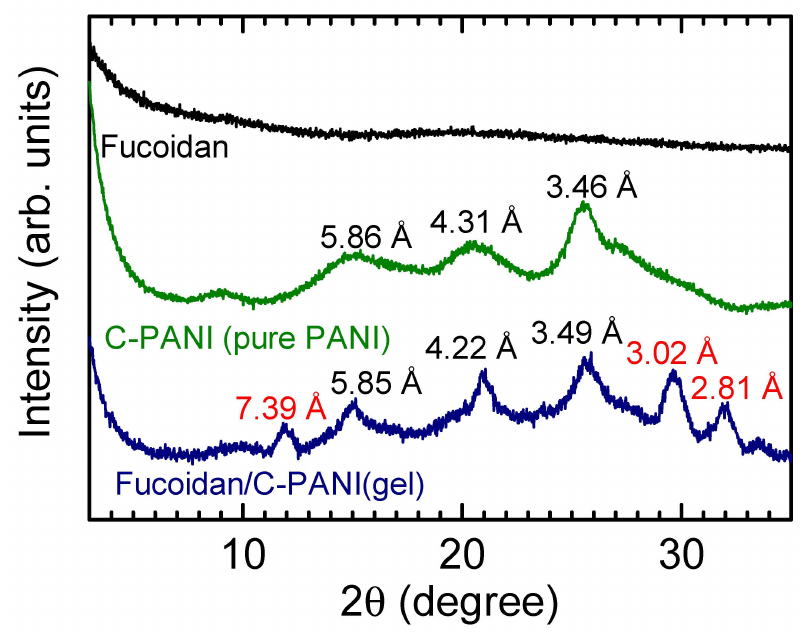
Figure 17. X-ray diffraction (XRD) profile of pure fucoidan (black line), C-PANI (pure polyaniline, green line) and fucoidan/C-PANI(gel) (blue